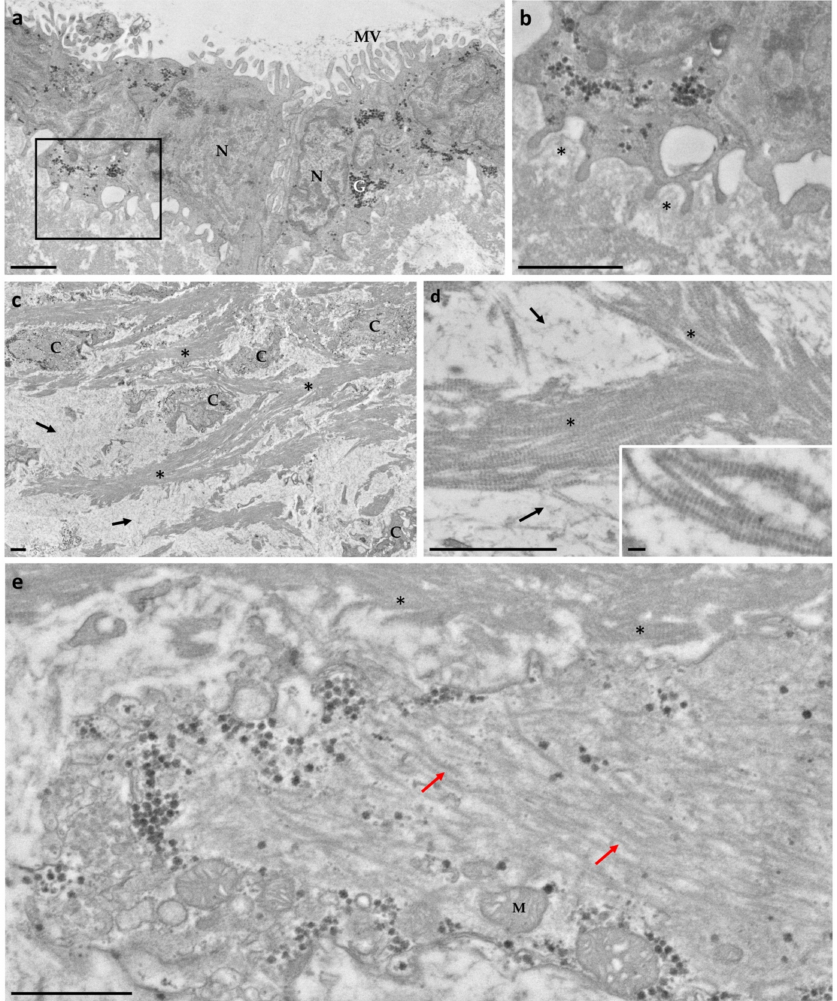
Figure 1. Electron microscopy of the ampulla obtained from P. canaliculata . ( a ) The external surface was covered by a monolayer of epithelial cells with numerous microvilli (MV). ( b ) Cell membrane protrusions connected the epithelial cells to the basement membrane (*). ( c ) Numerous cells (C) appeared to be embedded in the extracellular matrix, which consisted of collagen fibrils (*) spread or assembled into bundles. ( d ) Fibrillar structures observed in connective tissue: thin fibrils (arrows) and longitudinally sectioned collagen fibrils showing the typical banding (*). Insert: collagen fibrils at higher magnification. Scale bar = 100 nm. ( e ) Representative image of cell with abundant cytoplasmic filaments (red arrows). Mitochondria (M), glycogen granules and vesicles were arranged closely to the plasma membrane. Scale bar = 1 µ m. G = glycogen; N =